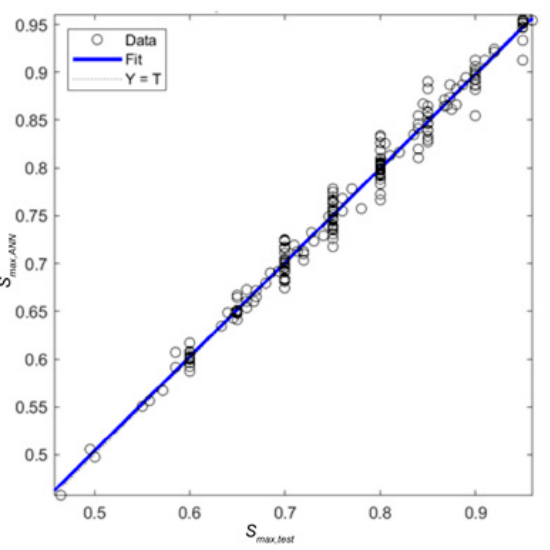
Figure 5. Regression plot for the proposed ANN for the output variable, S max . The expression for the blue line is: S max,ANN = 0.98 S max,test + 0.012 and R = 0.99238.